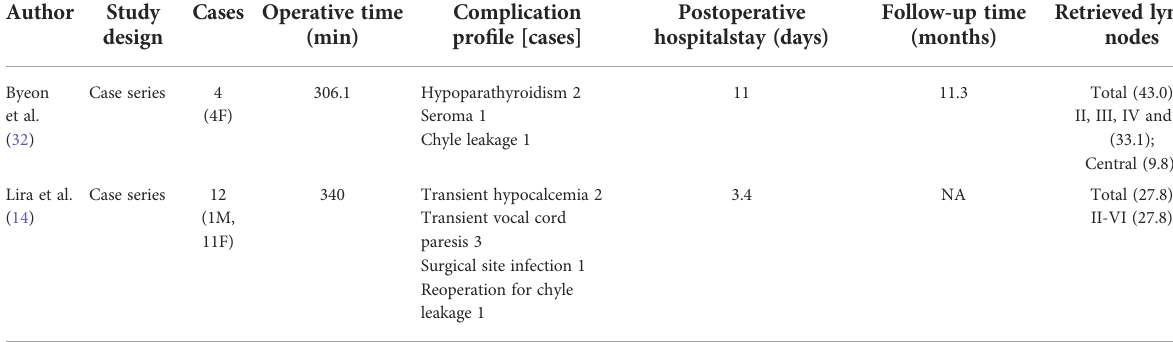
TABLE 3 Summary of studies of robotic retroauricular